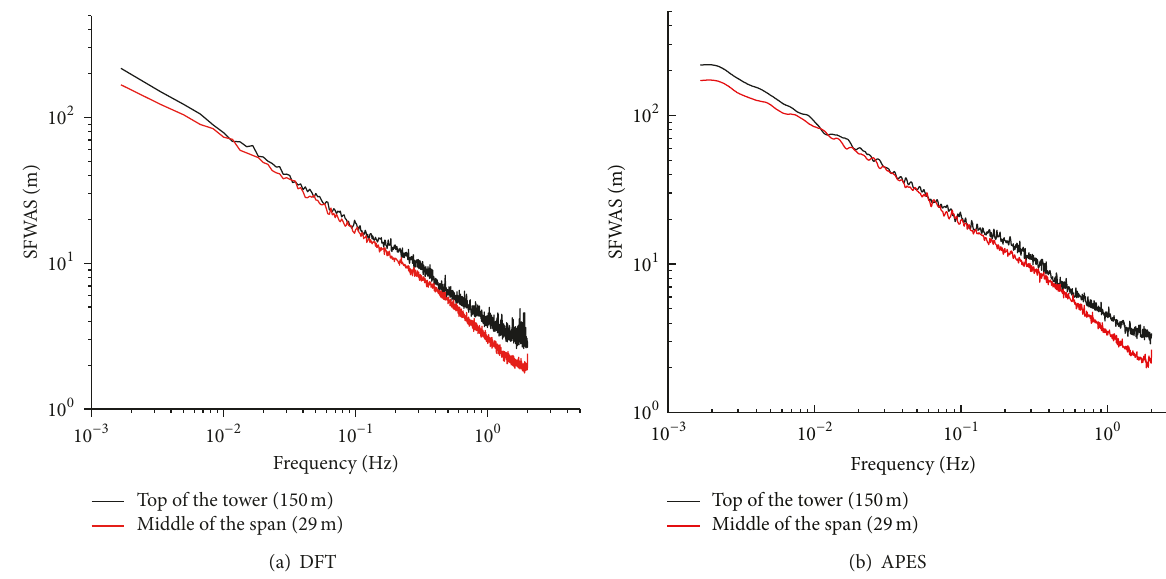
Figure 6: Standard deviation of measured FWASs obtained using the two methods.